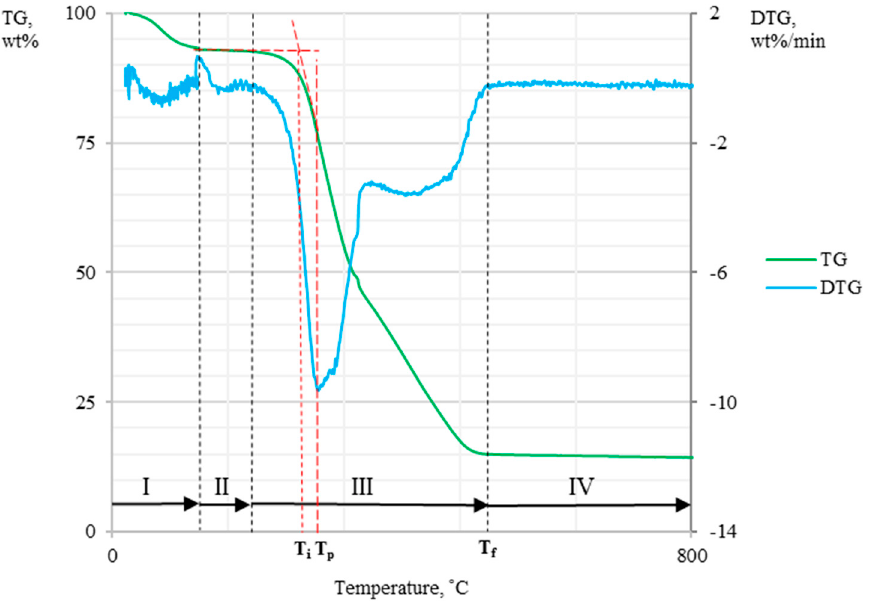
Figure 1. Schematic of TG and DTG curves (T i —ignition temperature, T p —maximum peak temper- ature, T f —burnout temperature, I—evaporation, II—oxidation mass gain, III—thermal decomposi- tion and burning, IV—burnout).